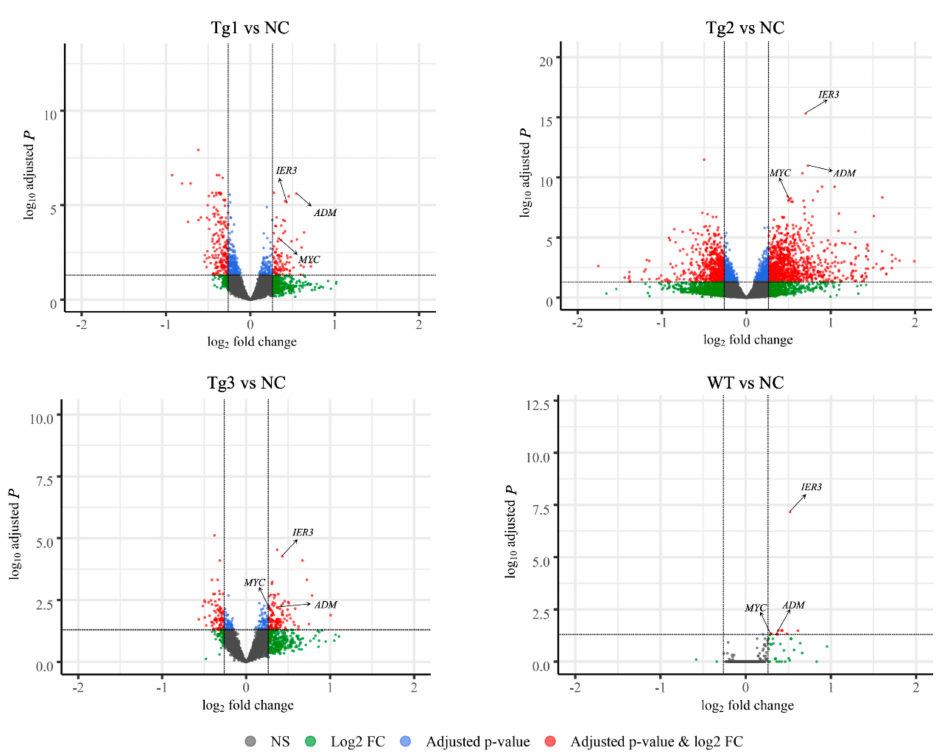
Figure 2. Volcano plots showing the adjusted P-values and the log2 fold change (FC) values of genes in the four genotype models (WT, Tg1-3) versus the control (NC) model. DEGs, indicated by the red dots, were identified as genes with an adjusted p -value of ≤ 0.05 and | log2 FC | > 0.26. MYC , IER3 , and ADM are indicated by the arrows.